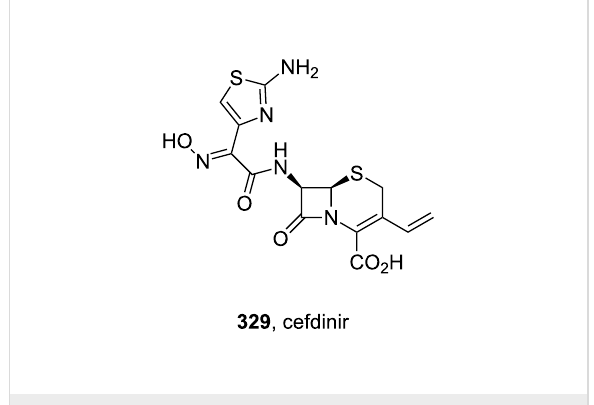
Figure 11: Structure of